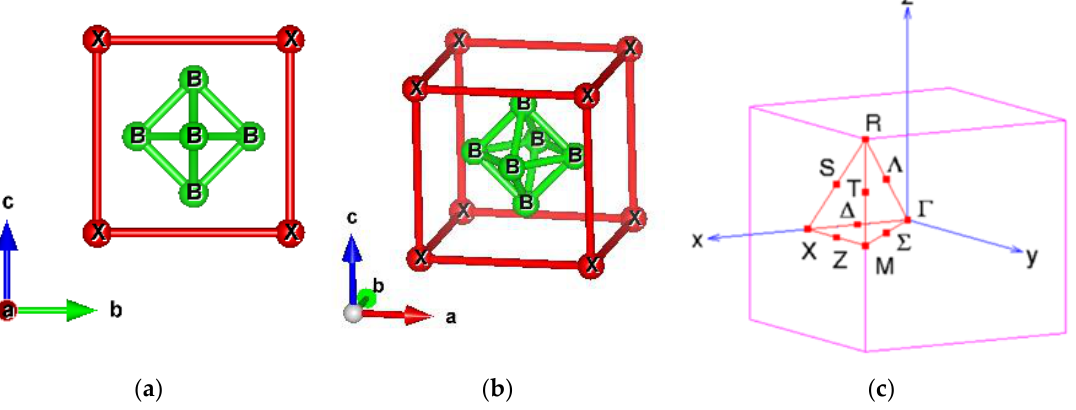
Figure 1. CsCl-type cubic crystal structure and Brillouin Zone of rare-earth hexaboride XB 6 . ( a ) Side view. ( b ) Oblique view. ( c ) Brillouin Zone and high symmetry k-points.